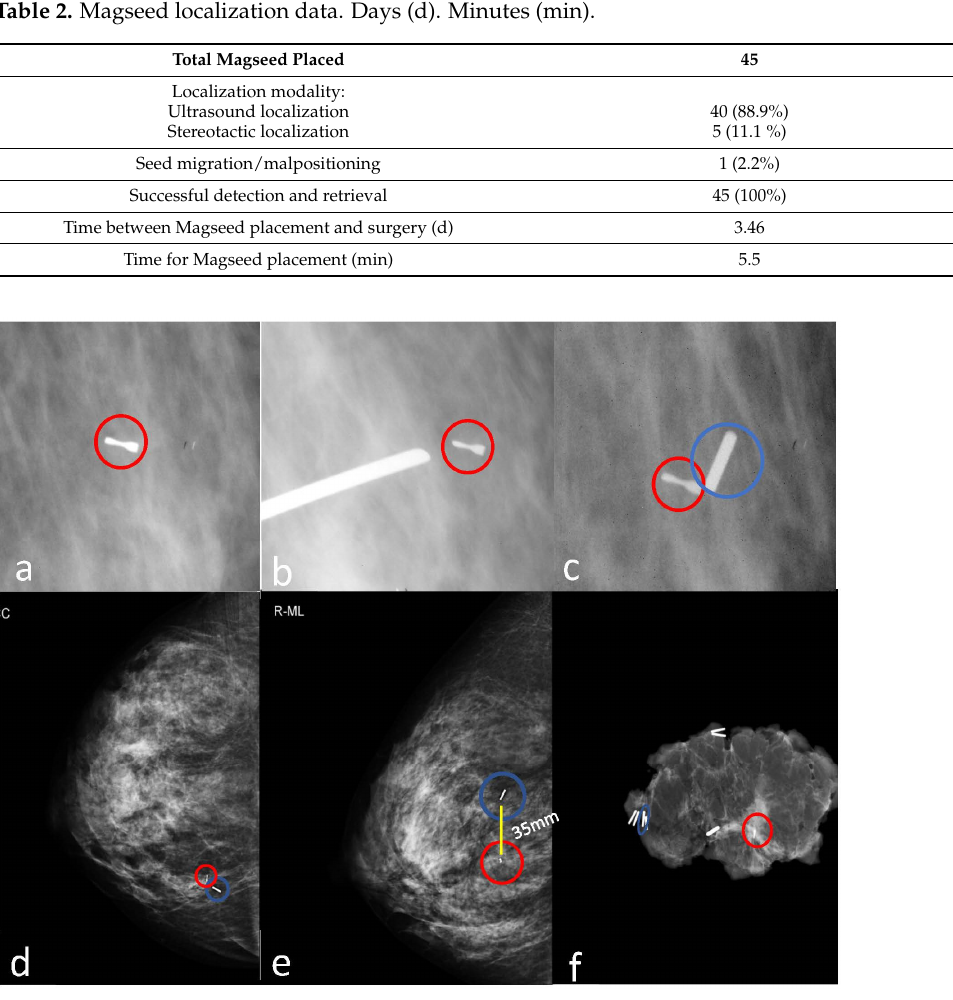
Figure 5. Misplaced Magseed. In ( a – c ), the placement of the Magseed (blue circle in c ) under stereotactic guidance in the site of a previous stereotactic biopsy with a metallic clip (the red circles). Preoperative mammography in two views ( d , e ) shows a cranial displacement of the Magseed (blue circles in e ) at a distance of 35 millimeters (mm) from the biopsy-clipped lesion (red circles). The surgical specimen radiogram reveals the Magseed (blue circle) and the clipped lesion (red circle) ( f ) correctly removed.